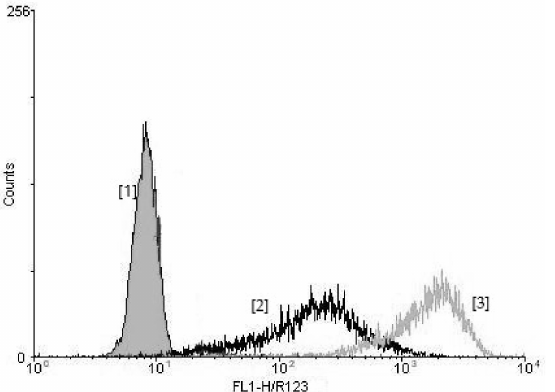
Figure 2. The rhodamine 123-fluorescence intensity of neutrophils without stimulation (control) [1] and exposed to Escherichia coli [2] and PMA [3] (in relative fluorescence units, i.e., the median channel of the fluorescing cell